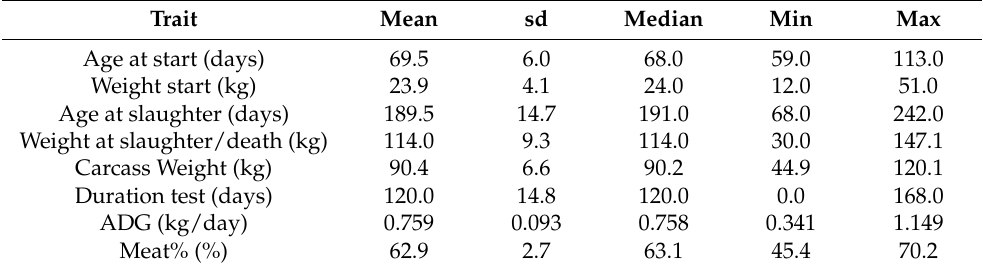
Table 2. Descriptive statistics of production traits and covariables for analyses at individual level (final data, N = 14,742